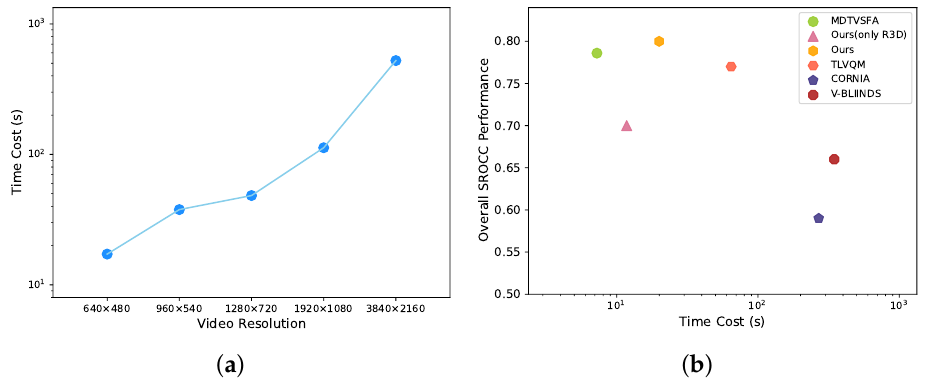
Figure 15. Runtime comparison. ( a ) Time costs in evaluating videos with different resolutions. ( b ) Time costs and overall performance comparison with different